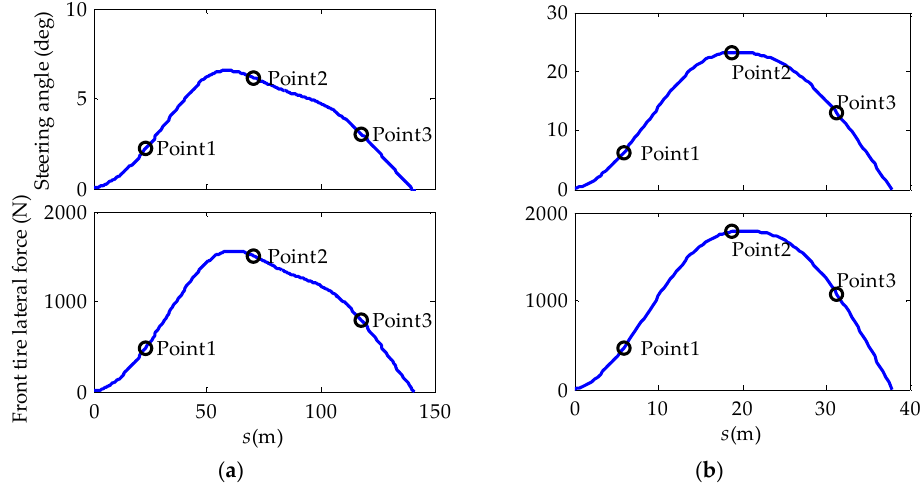
Figure 7. The steering angle and front tire lateral force of the model in ( a ) R = 30 m and U x = 45 km/h and ( b ) R = 8 m and U x = 25 km/h cases.